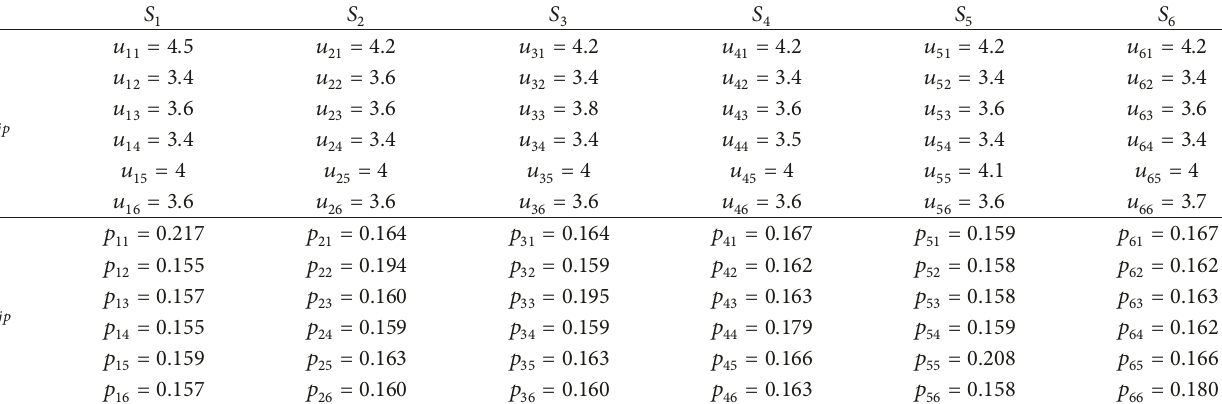
Table 5: Utility-probability value table.